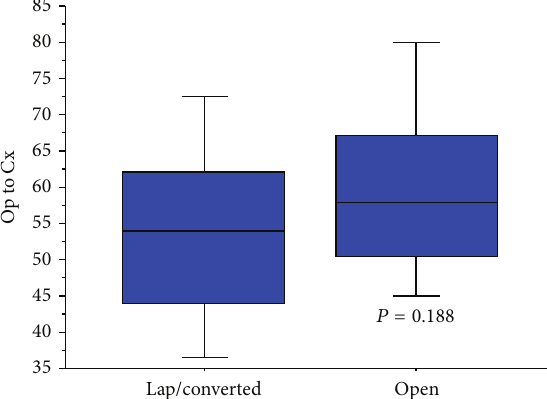
Figure 3: Association between laparoscopic surgery and shorter postoperative stay. Figure 4: Association between approach to resection and time to adjuvant chemotherapy, laparoscopic/converted versus open (for inclusion in online publication